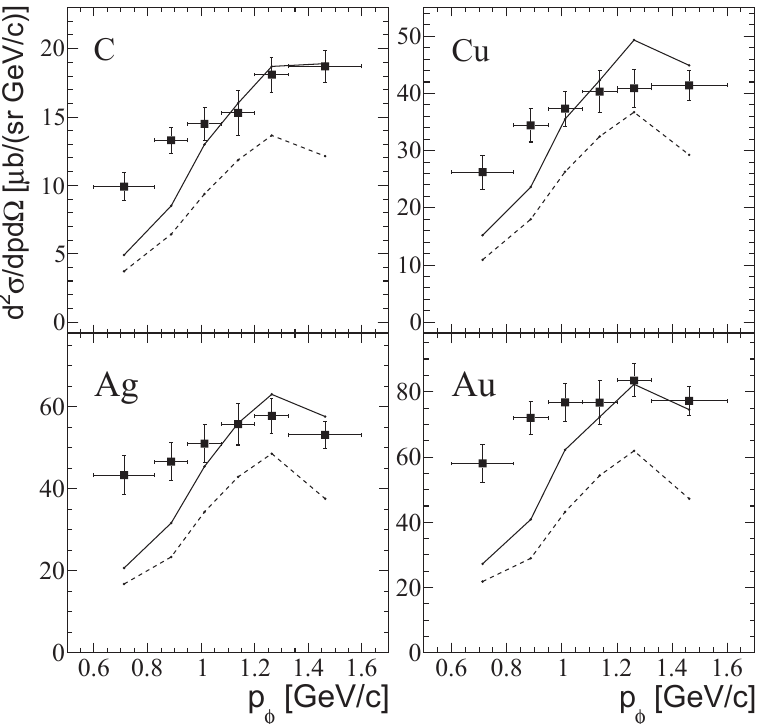
Fig. 6. Inclusive double-differential cross sections for φ production on C, Cu, Ag, and Au target, as functions of the φ momentum, compared with the predictions of Model 2 (dashed) and Model 3 (solid